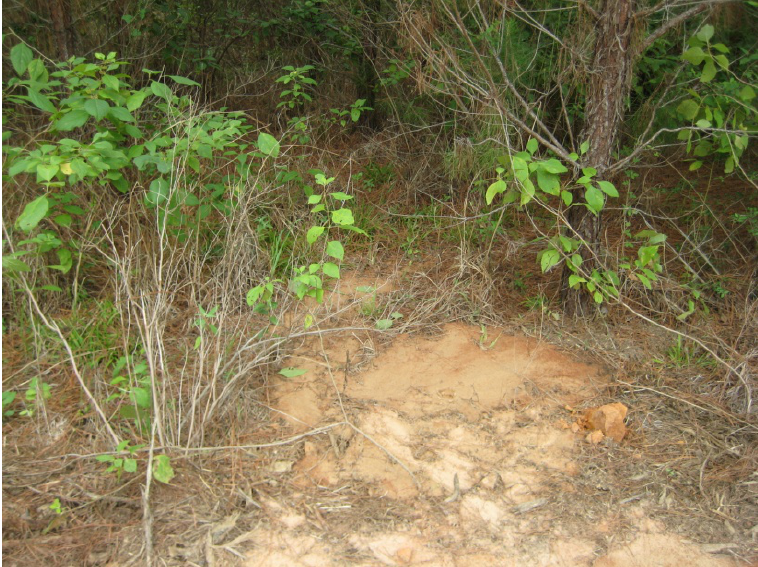
Figure 7. Sediment plume below the F2 natural gas well location trapped by riparian forest vegetation before entering the stream channel at the Alto Experimental Watersheds in Texas, USA.